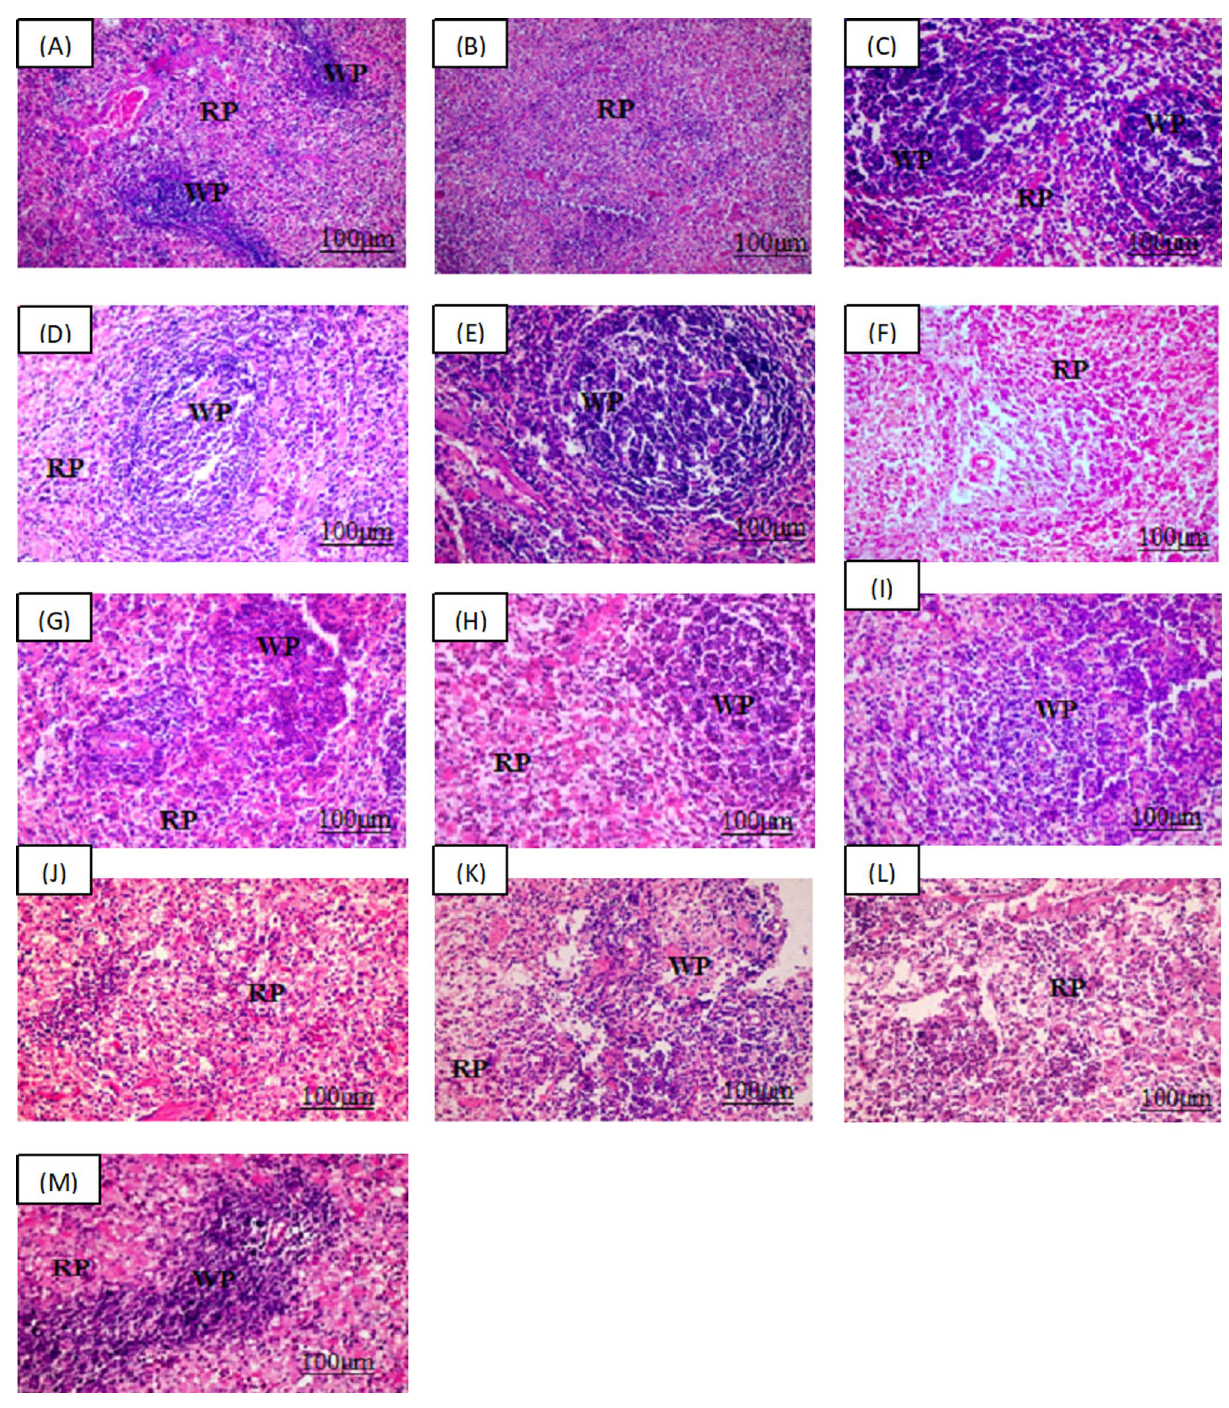
Figure 1. Histopathological Findings of the spleen. Group 1 ( A ) for normal control group showing normal white pulp (WP) and red pulp (RP), Group 2 ( B ) for dexamethasone control group. Group 3 ( C ) for Echinacea extract treated group. Pleurotus ostreatus group for low dose (200 mg/Kg) Group 4 ( D ) and high dose (400 mg/ Kg) Group 5 ( E ). Pleurotus columbinus low dose (200 mg/Kg) Group 6 ( F ) and high dose (400 mg/Kg) Group 7 ( G ). Pleurotus sajor-caju for low dose (200 mg/Kg) Group 8 ( H ) and high dose (400 mg/Kg) Group 9 ( I ). Lentinula edodes low dose (200 mg/Kg) Group 10 ( J ) and high dose (400 mg/Kg) Group 11 ( K ). Agaricus bisporus low dose (200 mg/Kg) Group 12 ( L ) and high dose (400 mg/Kg) Group 13 ( M ) (H&